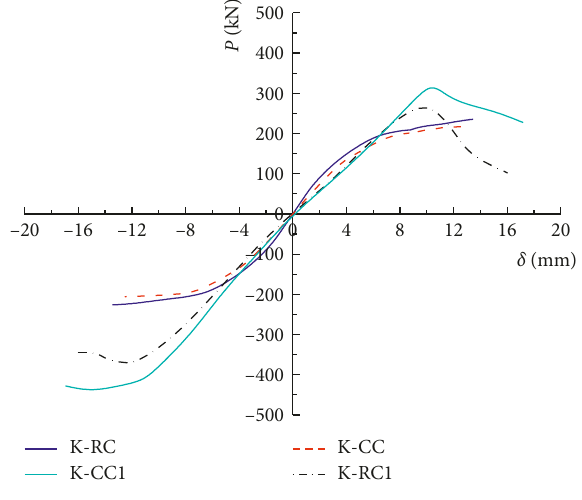
Figure 7: The skeleton curve.